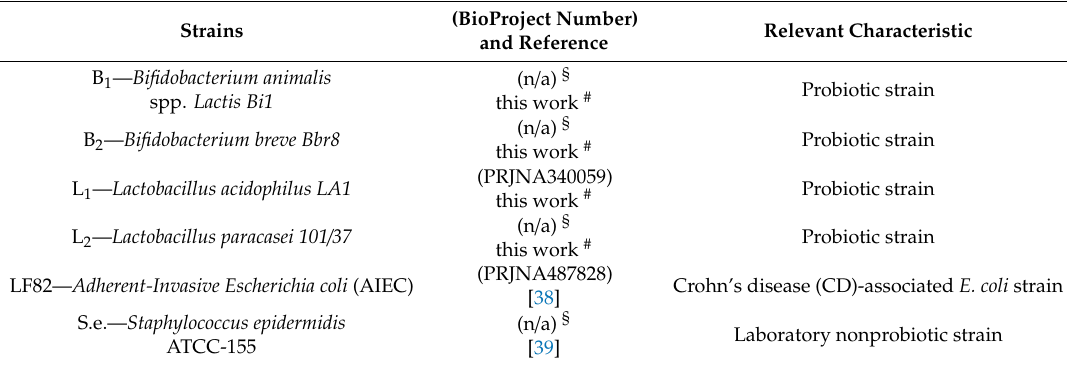
Table 1. Bacterial strains, origin and relevant characteristics used in this